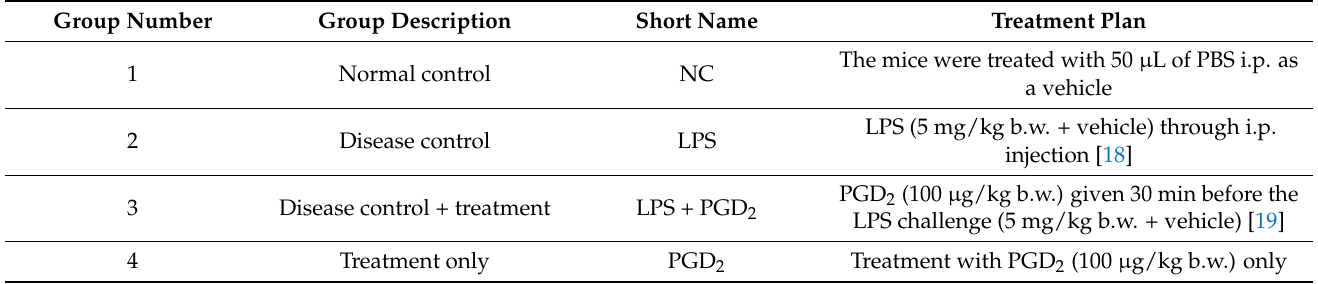
Table 1. Grouping of animals and treatment